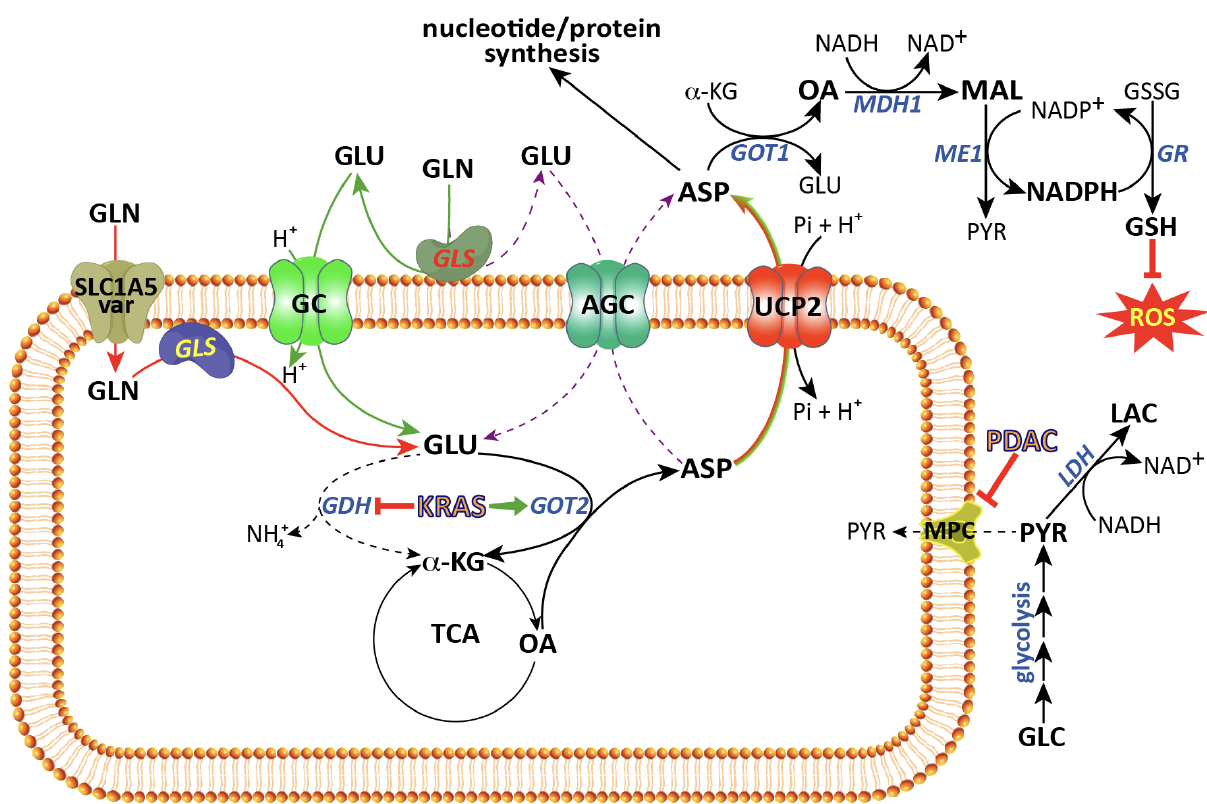
Figure 2. Role of mitochondrial solute carriers in PDAC metabolic rewiring. Depending on the localization of GLS either in the matrix or in the intermembrane space, two scenarios are proposed. In the first (red lines), glutamine is transported to the matrix through SLC1A5_Var and converted by the action of GLS localized in the matrix to glutamate which in turn is metabolized to aspartate and transported out of mitochondria by uncoupling protein 2 (UCP2). In the second (green and violet lines), glutamine is converted to glutamate by GLS localized in the intermembrane space and glutamate thus produced is transported to the matrix by glutamate carrier (GC) (green lines) or aspartate–glutamate carrier (AGC) (violet dashed lines) and glutamate-derived aspartate exists the mitochondria through UCP2 (green lines) or AGC itself (violet dashed lines), respectively. In the cytosol, aspartate reacts with α-KG by GOT1 to produce glutamate and oxaloacetate. The latter is reduced into malate by the action of MDH1 and malate is converted by ME1 to pyruvate and NADPH used for GSSG reduction and ROS control. Finally, in PDAC, mitochondrial pyruvate carrier (MPC) is downregulated hence reducing glucose flux towards OXPHOS and increases lactate production. trix glutamate-oxaloacetate transaminase; GR, glutathione reductase; LDH1, lactate dehydrogenase;